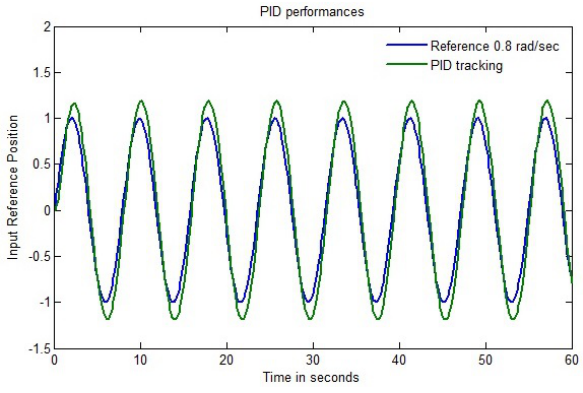
Figure 5: PID tracking performance.